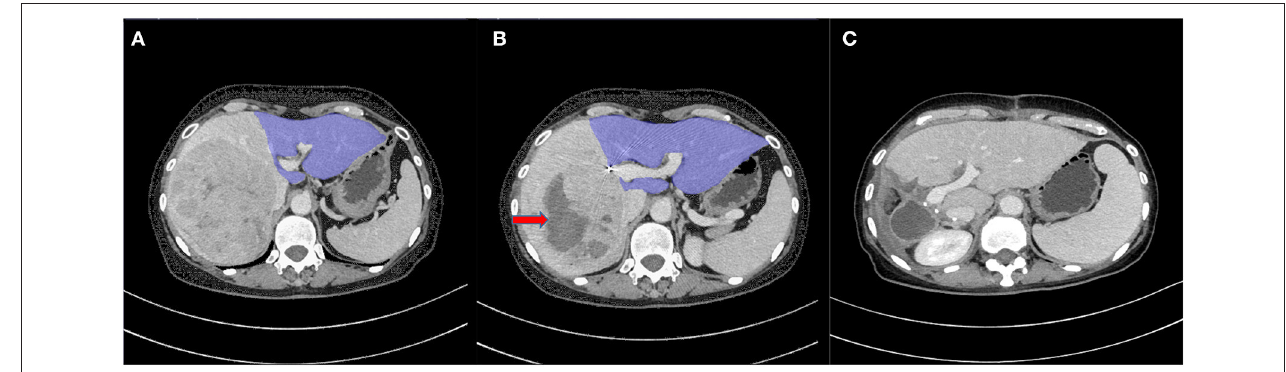
FIGURE 1 | (A) Contrast-enhanced CT image before sequential portal vein embolization (PVE) + radiofrequency ablation (RFA) (PVE + RFA) shows a 106mm × 103mm tumor in the right lobe. The future liver remnant (FLR) (the blue part) was 385ml (32%). (B) Eight days after PVE + RFA, the FLR had increased to 508ml (42%) (the blue part). Red arrow shows tumor necrosis induced by RFA. (C) CT image at follow-up 48 days after liver resection shows a continued FLR growth.